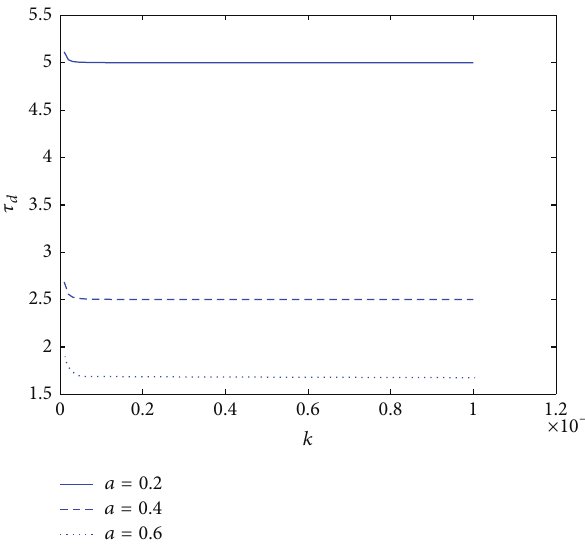
Figure 1: Damping time 𝜏 𝑑 of fast waves versus wavenumber k .